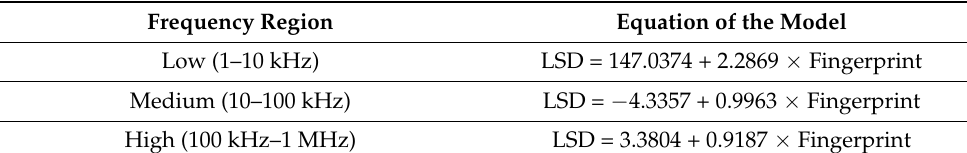
Table 9. Equation of the model for frequency regions at tap position 1.